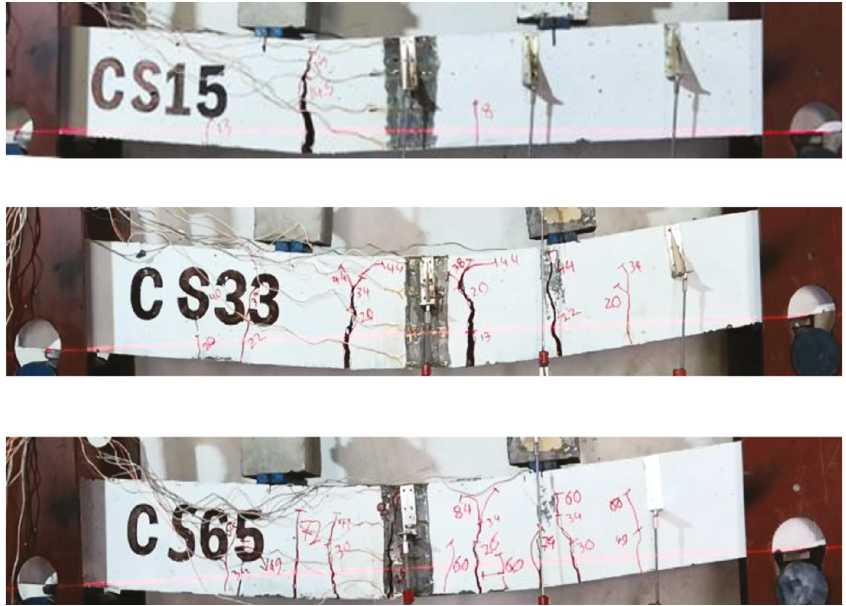
Figure 9: Crack propagation of small beams.